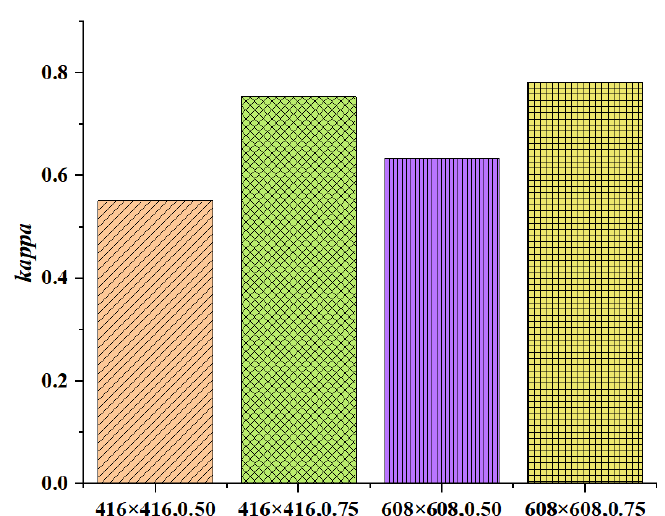
Figure 18. Class-wise recall.